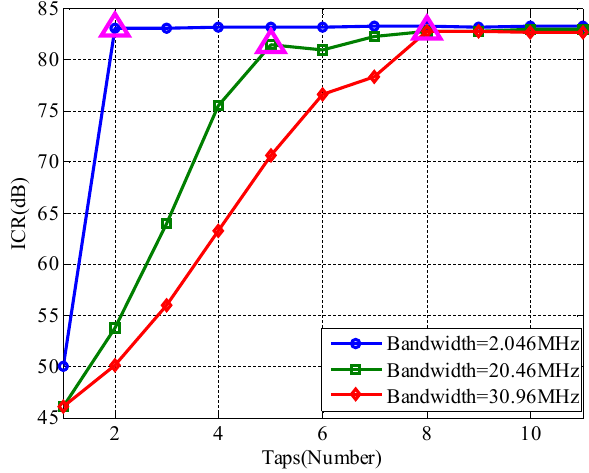
Figure 12. Impact of taps on ICR with different bandwidth.